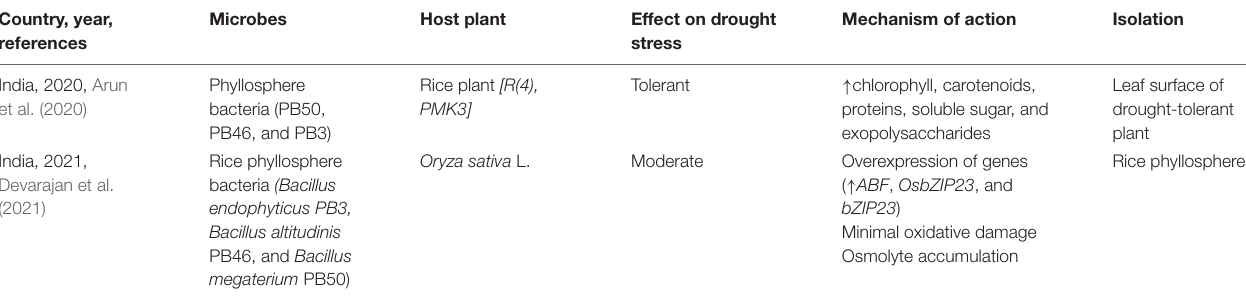
TABLE 3 | Phyllosphere mitigates drought